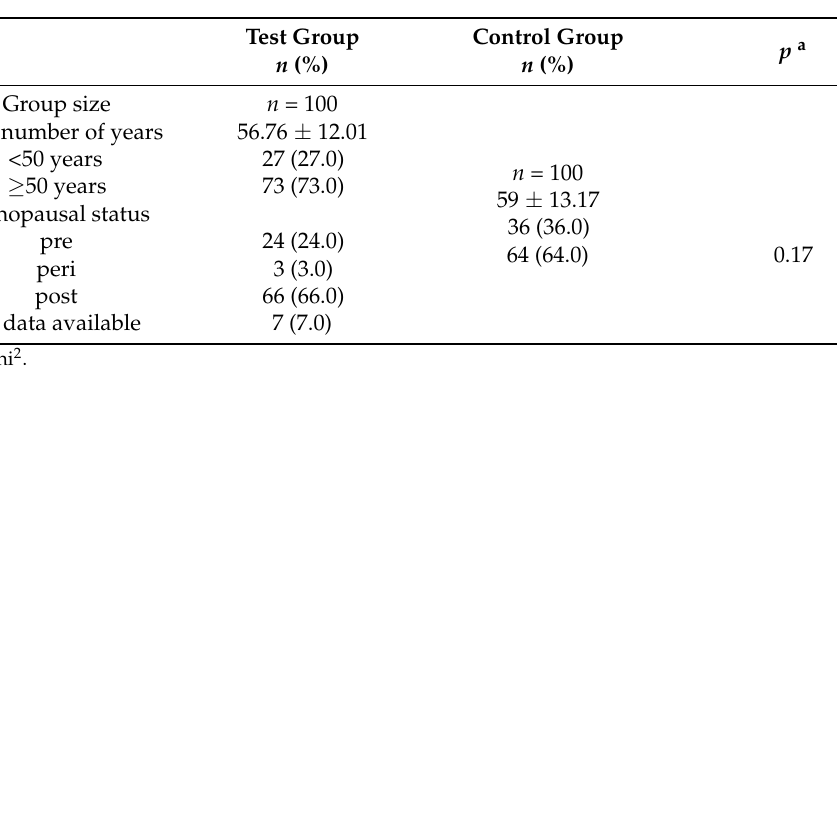
Table 1. Demographic characteristics of breast cancer patients (test group) and control